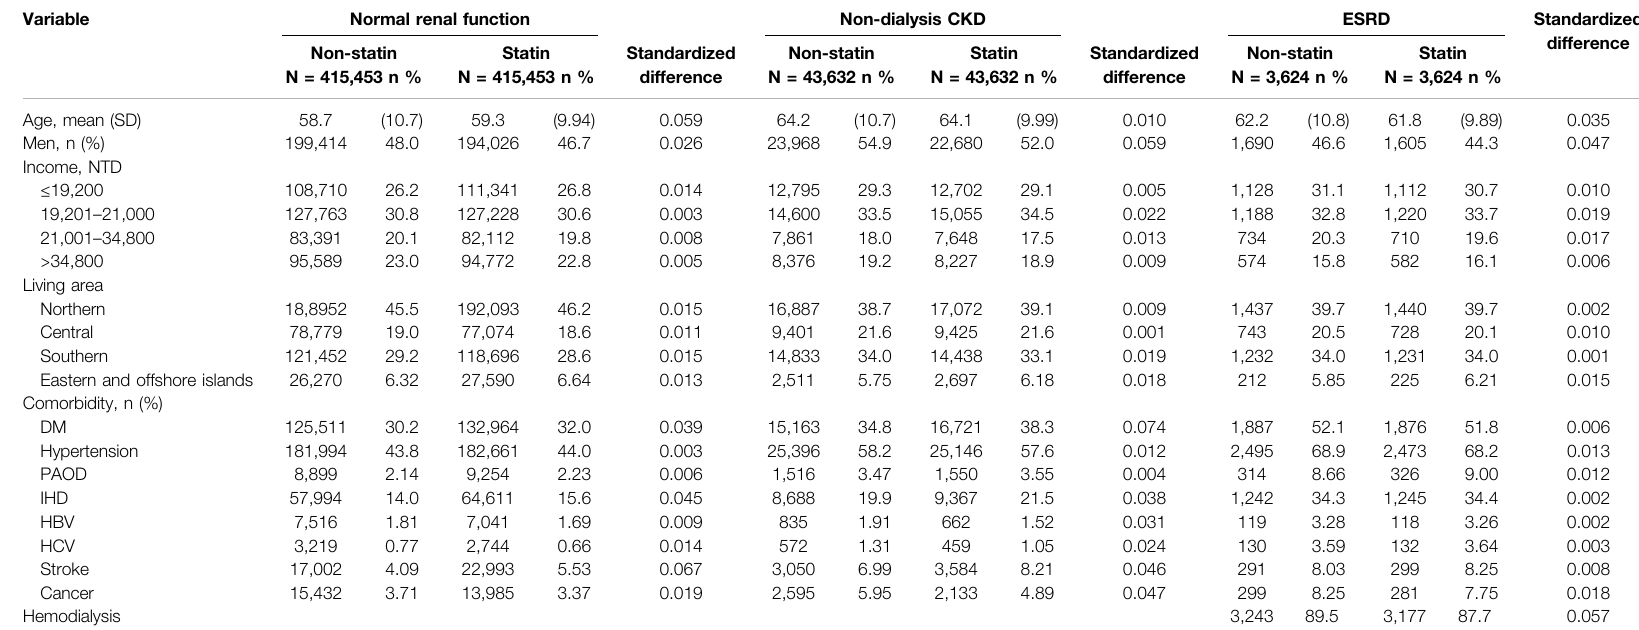
Abbreviations: CKD, chronic kidney disease; ESRD, end-stage renal disease; DM, diabetes mellitus; PAOD, peripheral arterial occlusive disease; IHD, ischemic heart disease; HBV, hepatitis B virus infection; HCV, hepatitis C virus